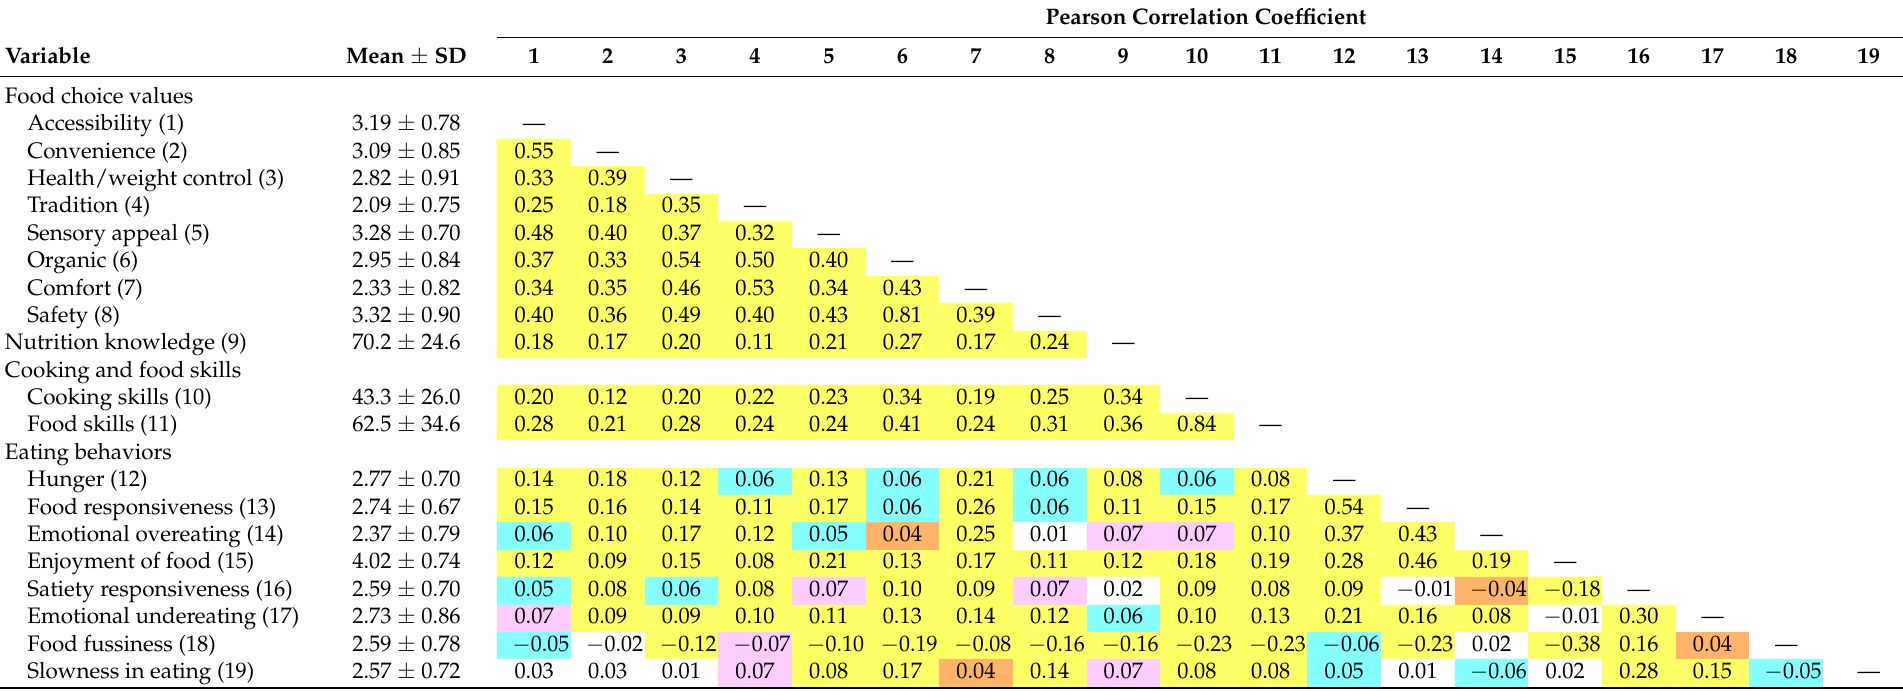
Table 2. Descriptive statistics of food choice values and food literacy variables characterized by nutrition knowledge, cooking and food skills, and eating behaviors ( n = 2231) 1